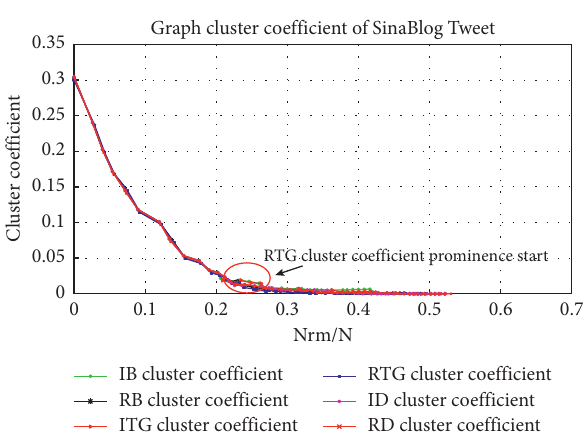
Figure 14: C G �( V,E ) result of SinaBlog Tweet.